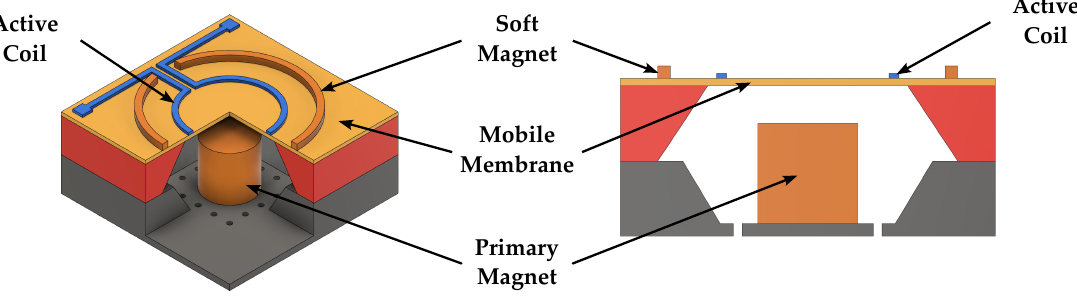
Figure 2. Schematic 3D view and cross section of an electromagnetic speaker employing the structure proposed in [41].